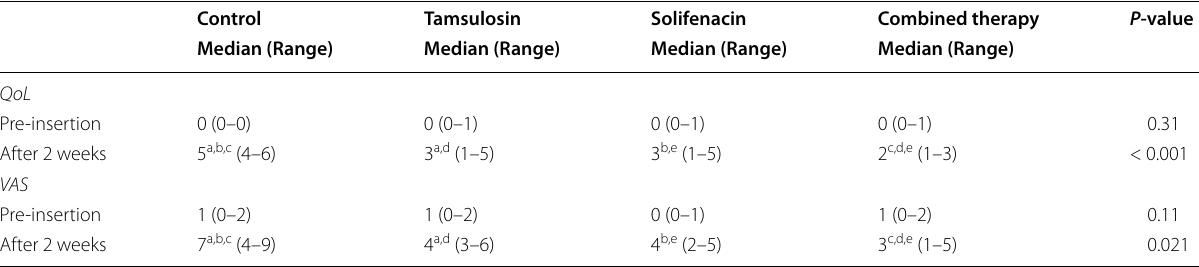
Similar letters (a, b, c, d, e) indicate significant difference QoL Quality of life; VAS visual analog